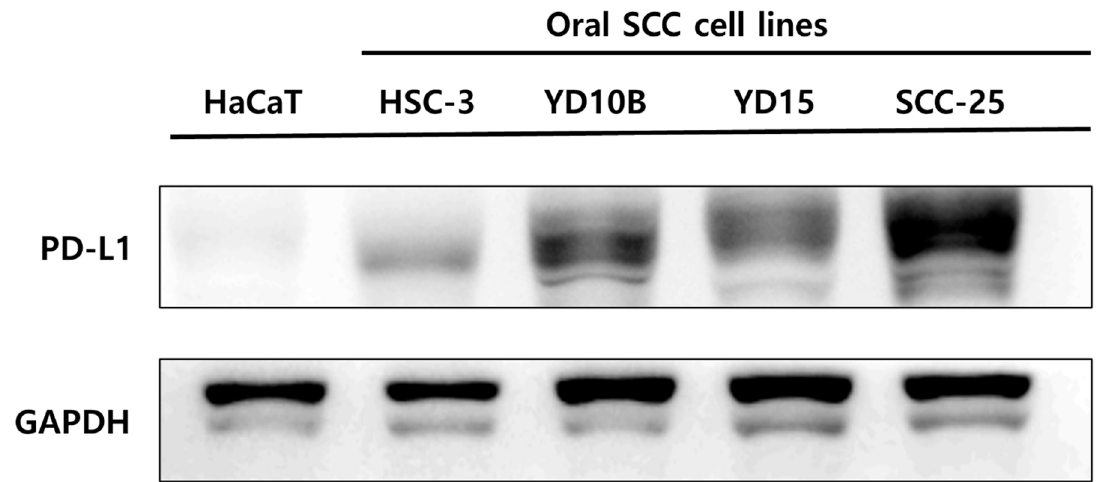
Figure 2. Western blot assay of the PD-L1 expression in oral squamous cell carcinoma cells. PD-L1 expression was the highest in SCC-25 cells.